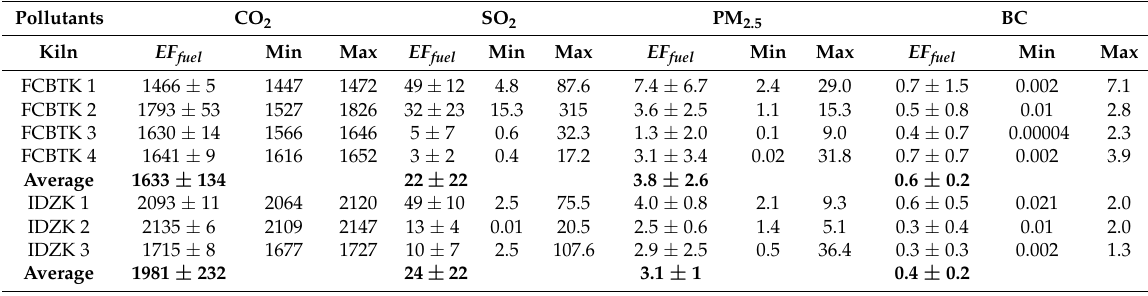
Table 4. Average EF fuel (g/kg) with standard deviations along with its minimum and maximum value for different pollutants in all the measured kilns. CO 2 values have been rounded off to the nearest whole number.